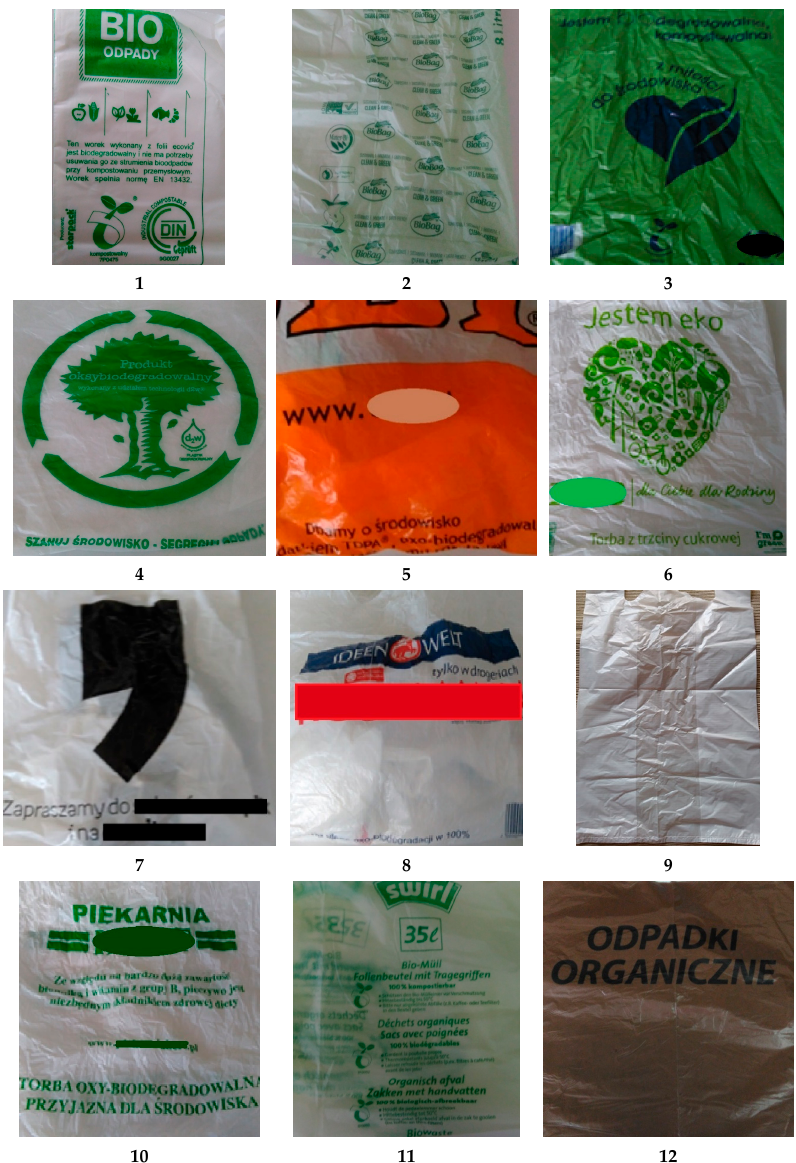
Figure 1. Appearance of shopping bags and waste disposal bags selected for the study [photo F. Markowicz]